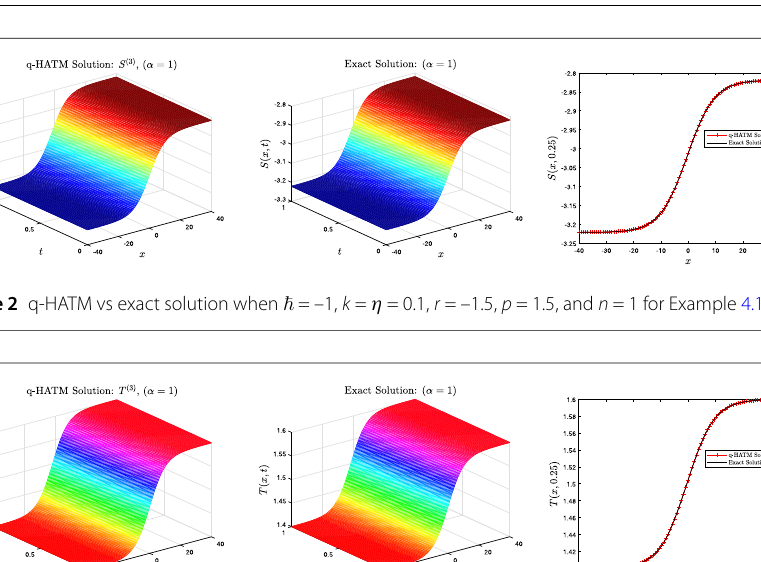
Figure 1 q-HATM vs exact solution when (cid:2) = –1, k = η = 0.1, r = –1.5, p = 1.5, and n = 1 for Example 4.1